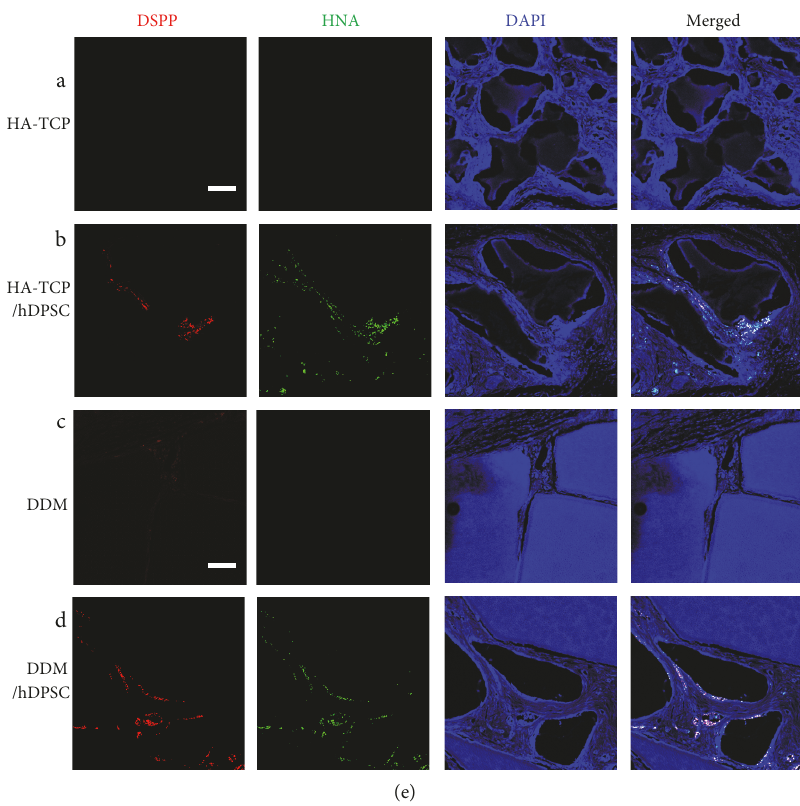
Figure 7: Immunohistochemical localization of osteogenic and dentinogenic markers. Para ffi n sections of the transplants were incubated with anti-OPN antibody (a), anti-OCN antibody (b), anti-ONT antibody (c), anti-BSP antibody (d), and anti-DSPP antibody (e). Signal of markers was shown as red. Nuclei of human cells and DNA in tissues were stained by anti-HNA antibody (green) and DAPI (blue), respectively. (A), transplants of HA-TCP only; (B), transplants of HA-TCP with hDPSCs; (C), transplants of DDM only; (D), transplants of DDM with hDPSCs. Scale bar: 100 μ